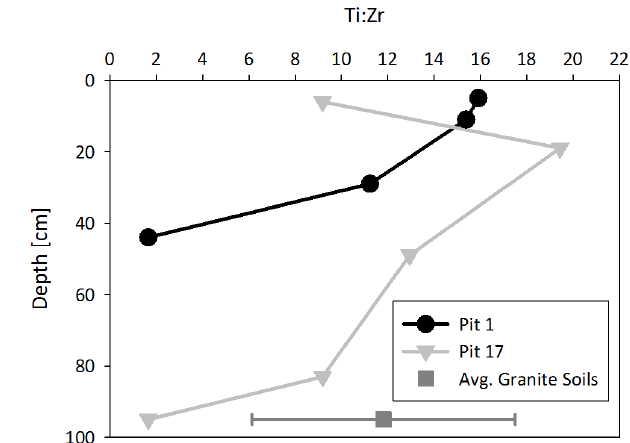
Figure 4. Depth profiles of fine-earth fraction Ti:Zr in the profiles location on quartzite relative to average Ti:Zr of soils derived from granite in the study catchment.